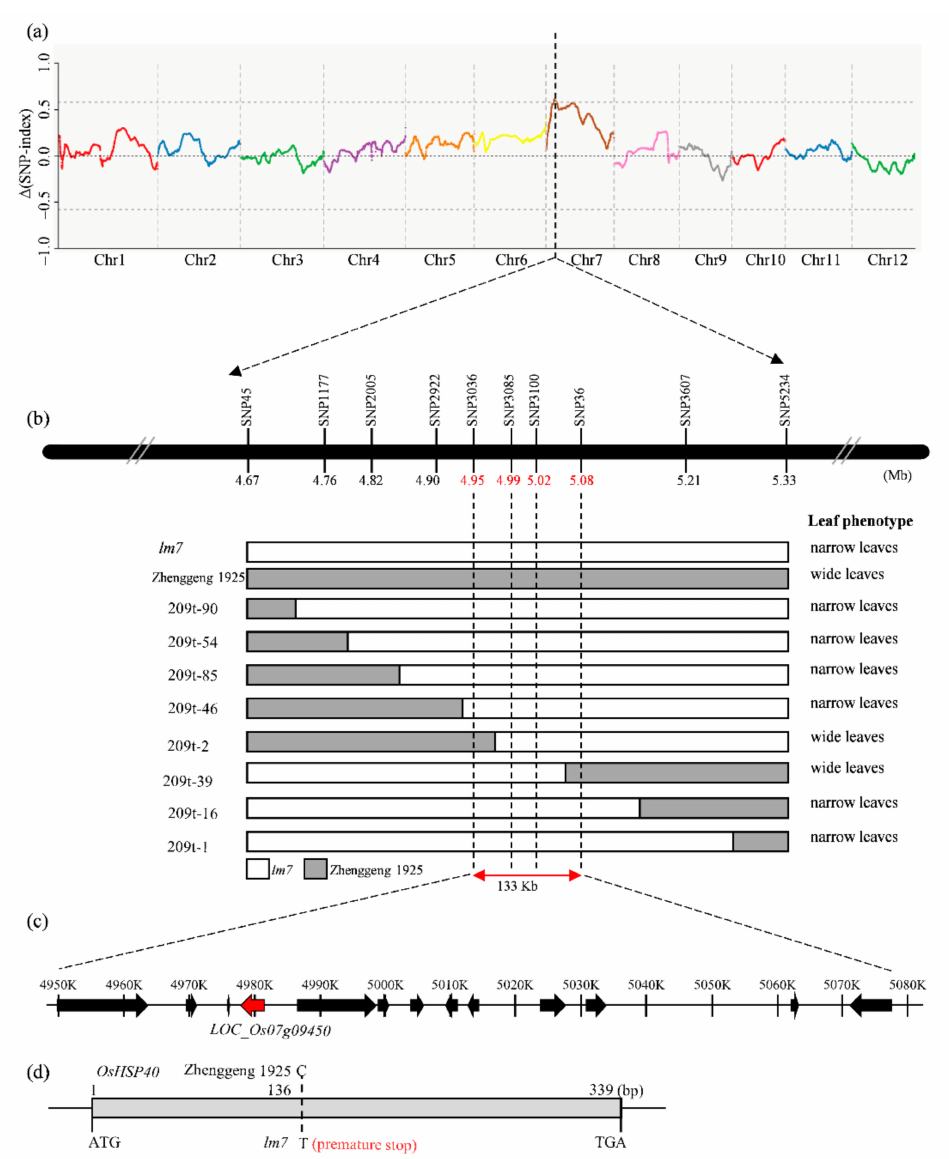
Figure 3. Mapping and cloning of LM7 by bulked segregant analysis using sequencing. ( a ) Distri- bution of ∆ index of single nucleotide polymorphism (SNP) across 12 chromosomes. ∆ (SNP-index) means the absolute value of the difference of SNP index between the bulked pool and Zhenggeng 1925. ( b ) SNP screening of 99 F 2 individuals originating from lw7 × Zhenggeng 1925 narrowed down the location of the LW7 locus to a 133 kb region bounded by markers SNP3036 and SNP36 on chromo- some 7. Numbers below the chromosome indicate the physical position of markers. White and gray indicates the lw7 and Zhenggeng 1925 background respectively. ( c ) Physical position of the LW7 locus. The arrows represent 13 annotated ORFs in the 133 kb fine-mapping interval according to the rice MSU 7 reference genome. LOC_Os07g09450 in red is the candidate gene for LW7. ( d ) CDS structure of candidate gene LW7/OsHSP40 (LOC_Os07g09450) and mutation site. Sequence analysis revealed a C-to-T nucleotide mutation, which results in forming stop codon in lw7